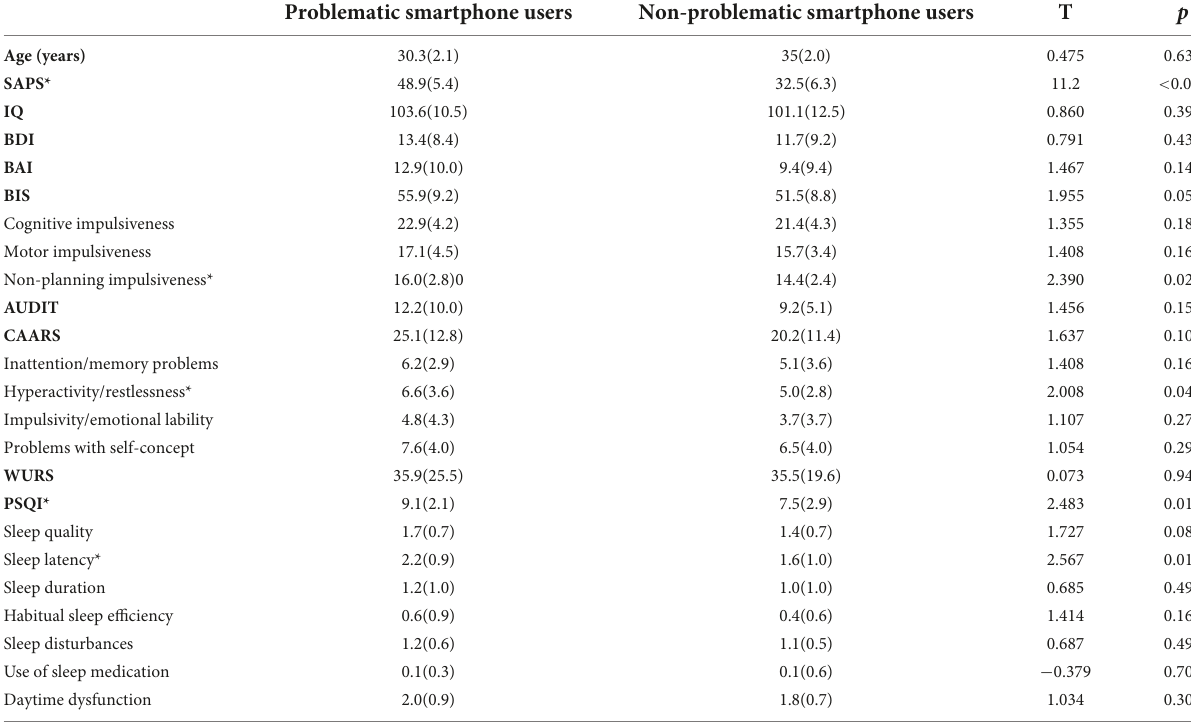
TABLE 1 Demographic and clinical characteristics of